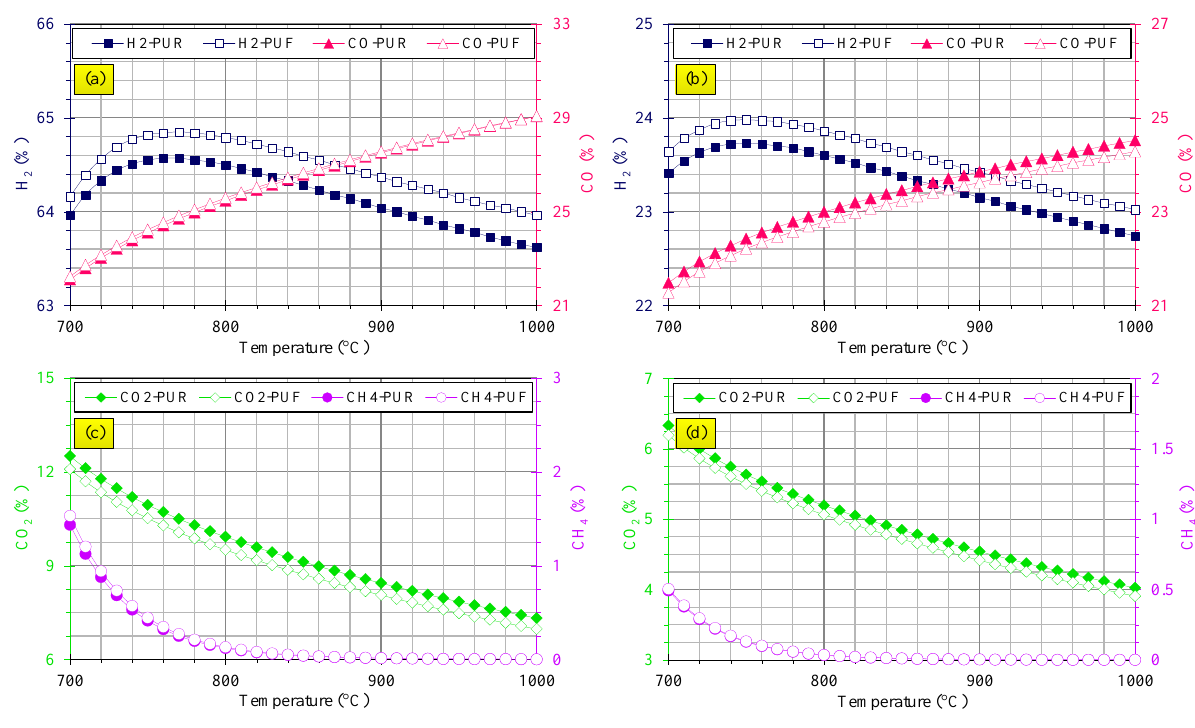
Figure 3. Effects of gasification temperature of waste flexible and rigid PU foams on ( a ) H 2 and CO yields in steam gasification, ( b ) H 2 and CO yields in air gasification, ( c ) CO 2 and CH 4 yields in steam gasification and ( d ) CO 2 and CH 4 yields in air gasification.